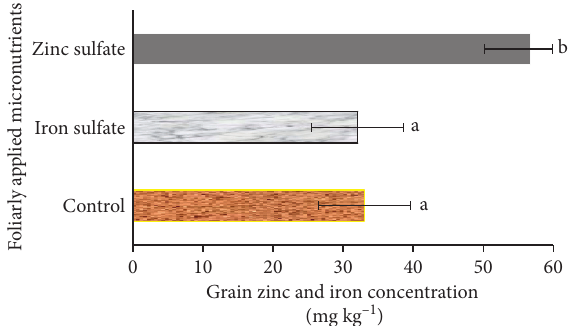
Figure 1: The effect of foliar application of ZnSO grain Zn and Fe concentrations (mg kg − 1 ). Bars labeled with different letters are significantly different from each other.